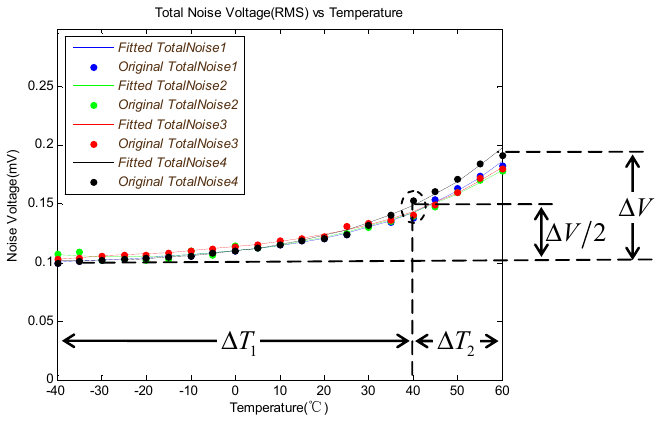
Figure 7. u N _ TOTAL ( RTO ) versus temperature curve. Figure 7. versus temperature curve.